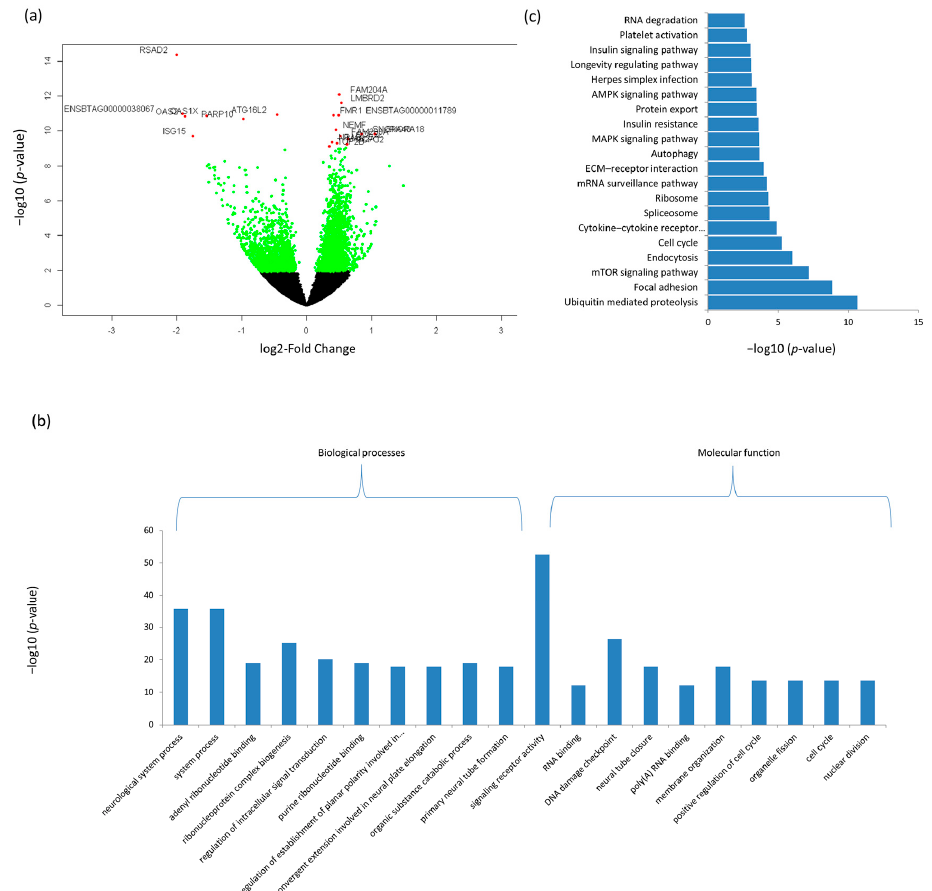
Figure 2. Differentially expressed genes and their enriched GO terms and KEGG pathways in ileum tissues. ( a ) Differentially expressed mRNAs; ( b ) top GO terms and ( c ) KEGG pathways. MAPK: Mitogen-activated protein kinase; mTOR: Mechanistic target of rapamycin.